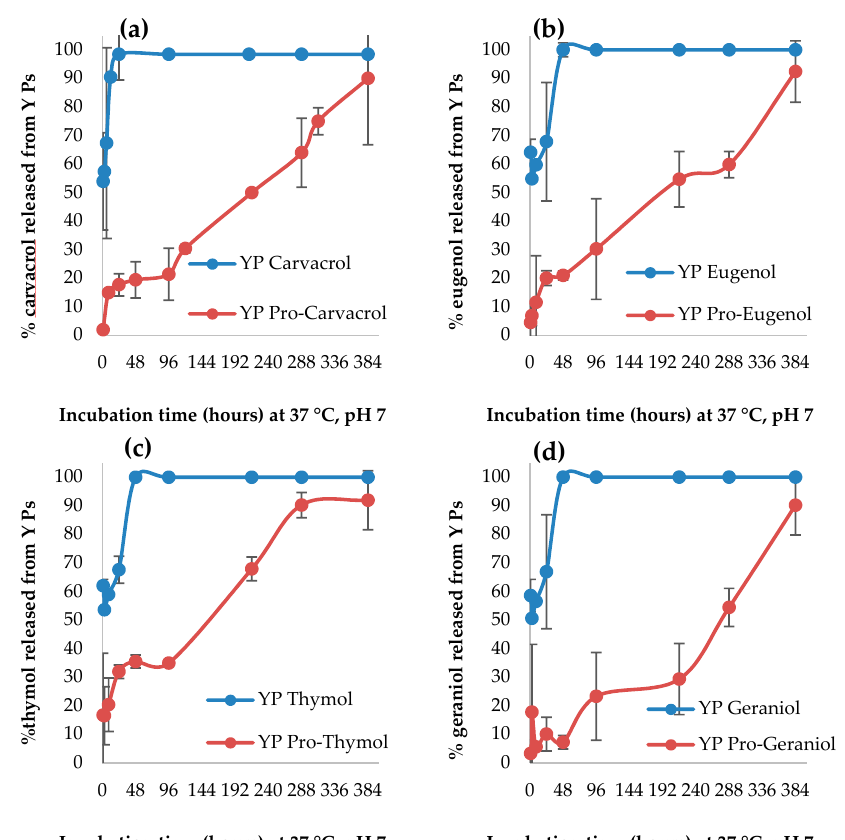
Figure 3. Kinetics of terpene release from YP terpene and YP pro-terpene containing ( a ) carvacrol, ( b ) eugenol, ( c ) thymol, and ( d ) geraniol. Samples were incubated in 0.1 M phosphate buffer saline (PBS, pH 7) at 37 °C at a concentration of 1 mg terpene/mL.